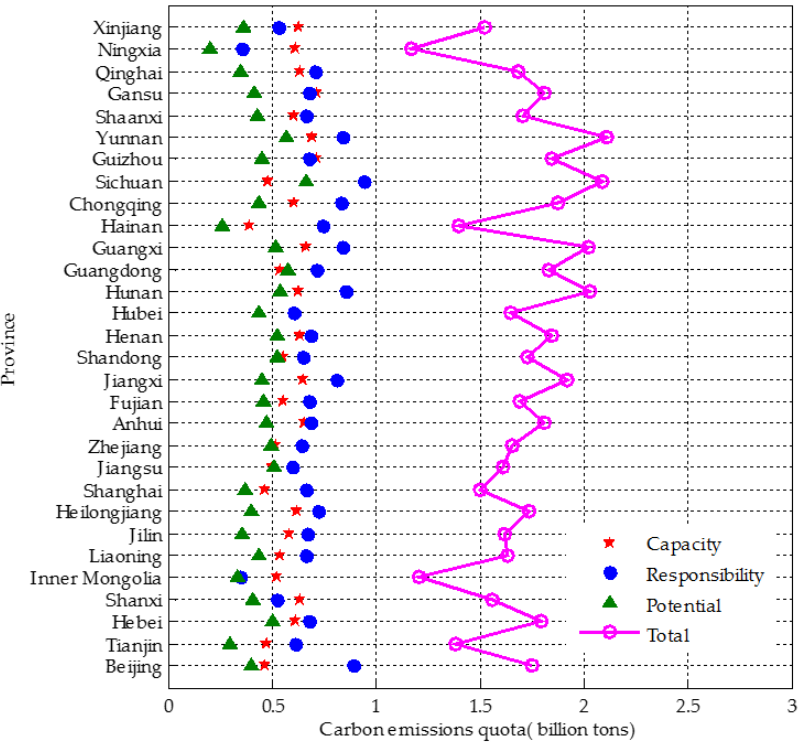
Figure 3. Carbon emission quota on indicators and the total for each